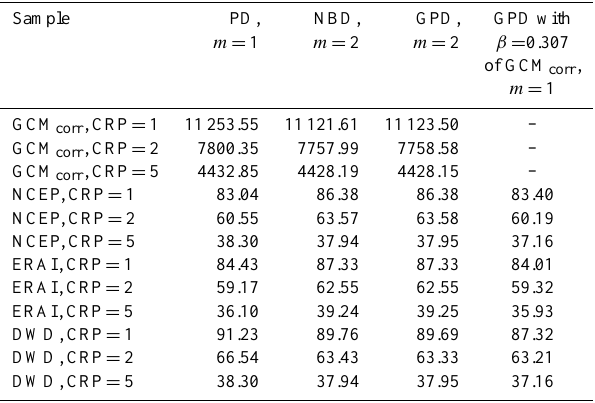
Table 1. BIC for some samples of winter storm in Germany accord- ing to Karremann et al. (2014) ( n = 4092 for GCM corr , otherwise n =